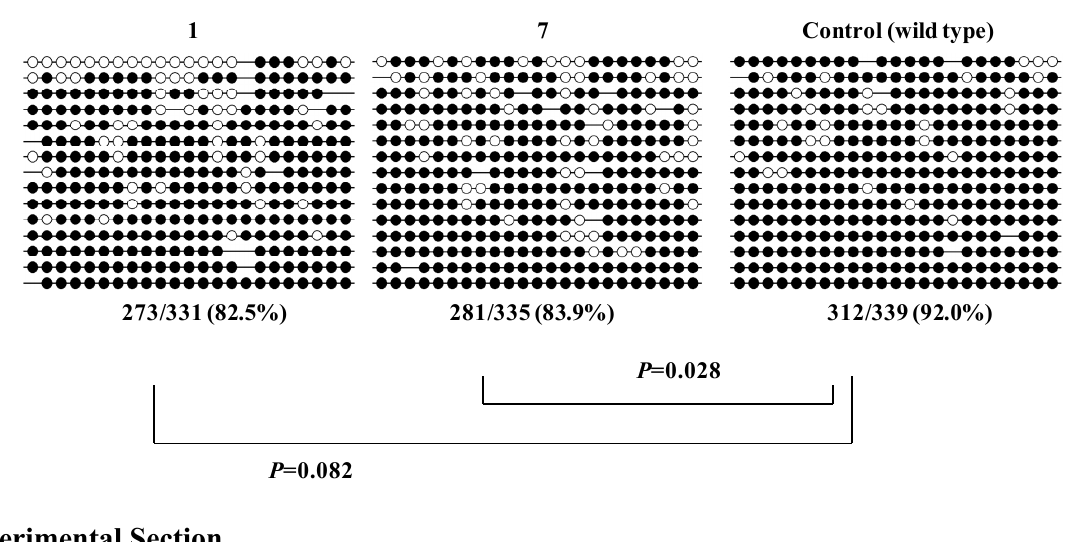
Figure 3. Methylation analysis of satellite 2 repeats in targeted human iPS cells. Open circles and closed circles denote unmethylated and methylated CpG sites,